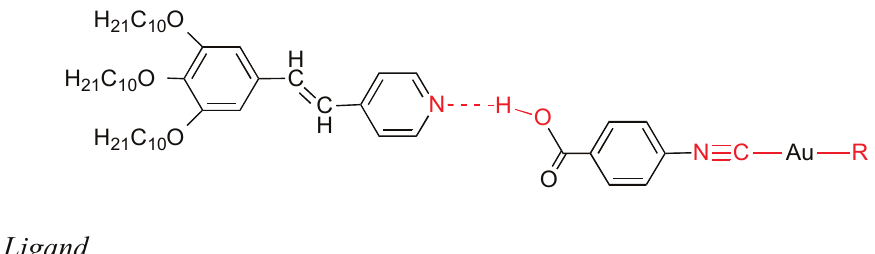
F , C F OC H . 6 5 6 4 10 21